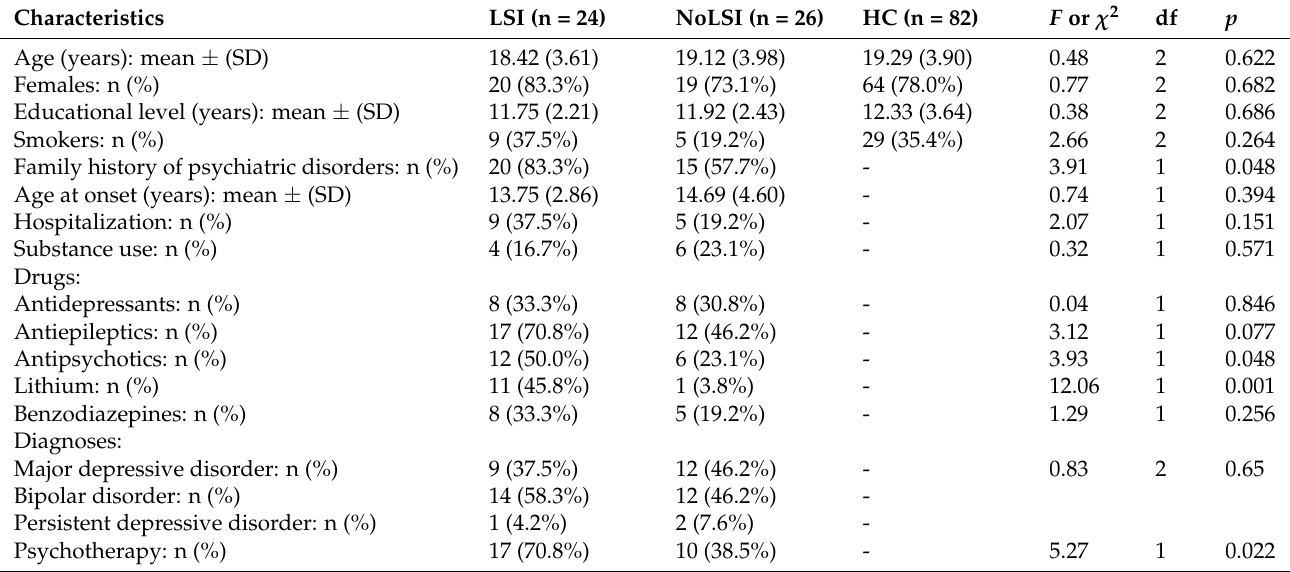
Table 1. Sociodemographic and clinical characteristics of LSI, NoLSI and HC.